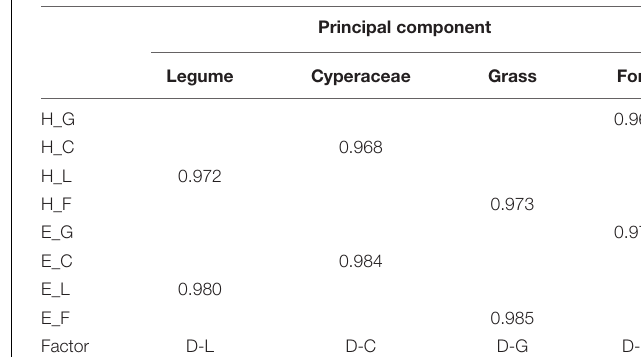
TABLE 3 | The score matrix of the principal component analysis of the diversity of each functional